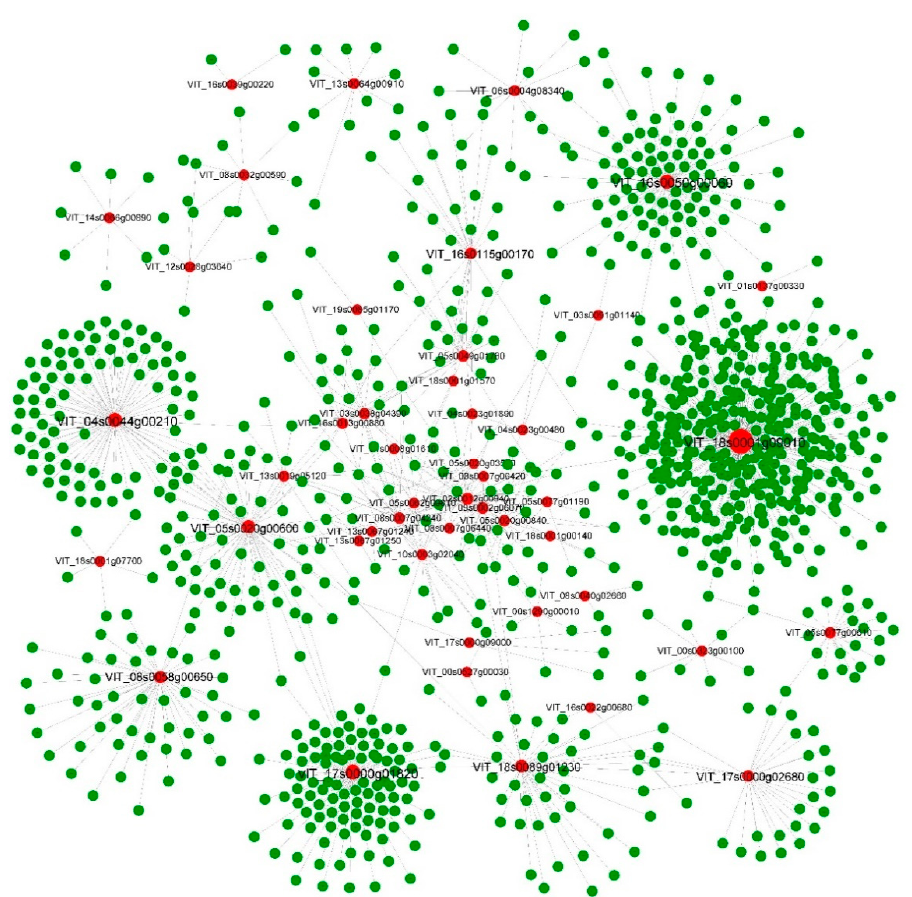
Figure 5. The core network of regulators includes the inner network of the DNB genes and the outer network ofDNB genes and their surrounding